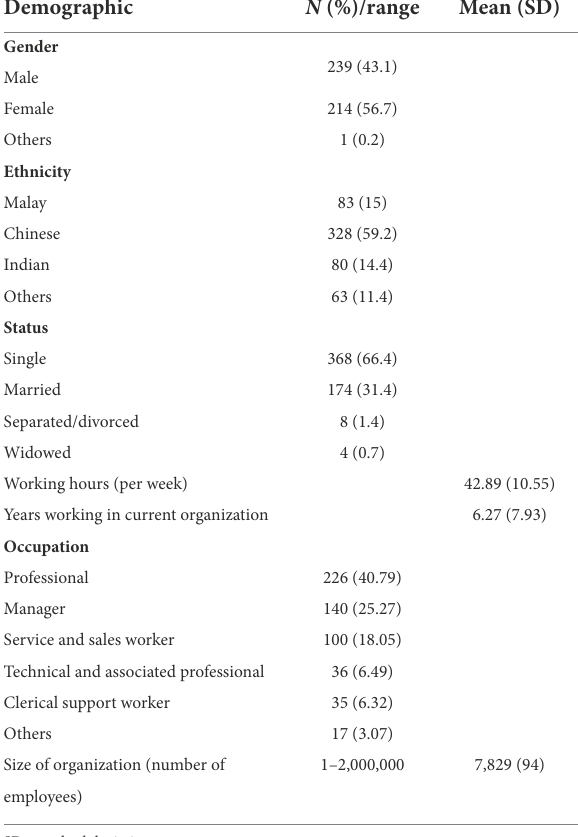
TABLE 1 Demographic information of participants ( N =